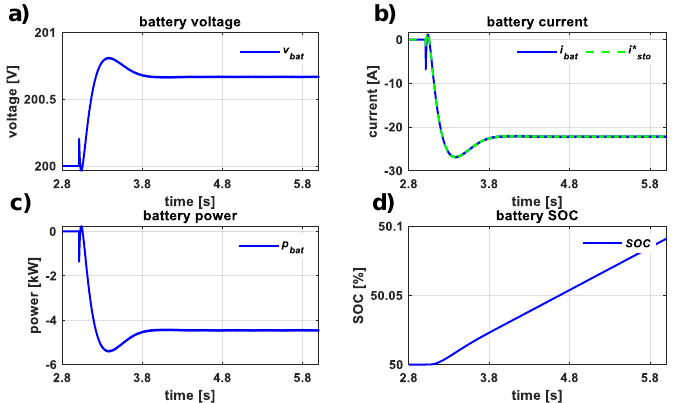
Figure 12. BESS time behavior: ( a ) voltage; ( b ) current; ( c ) power; ( d ) State of Charge ( SOC ).